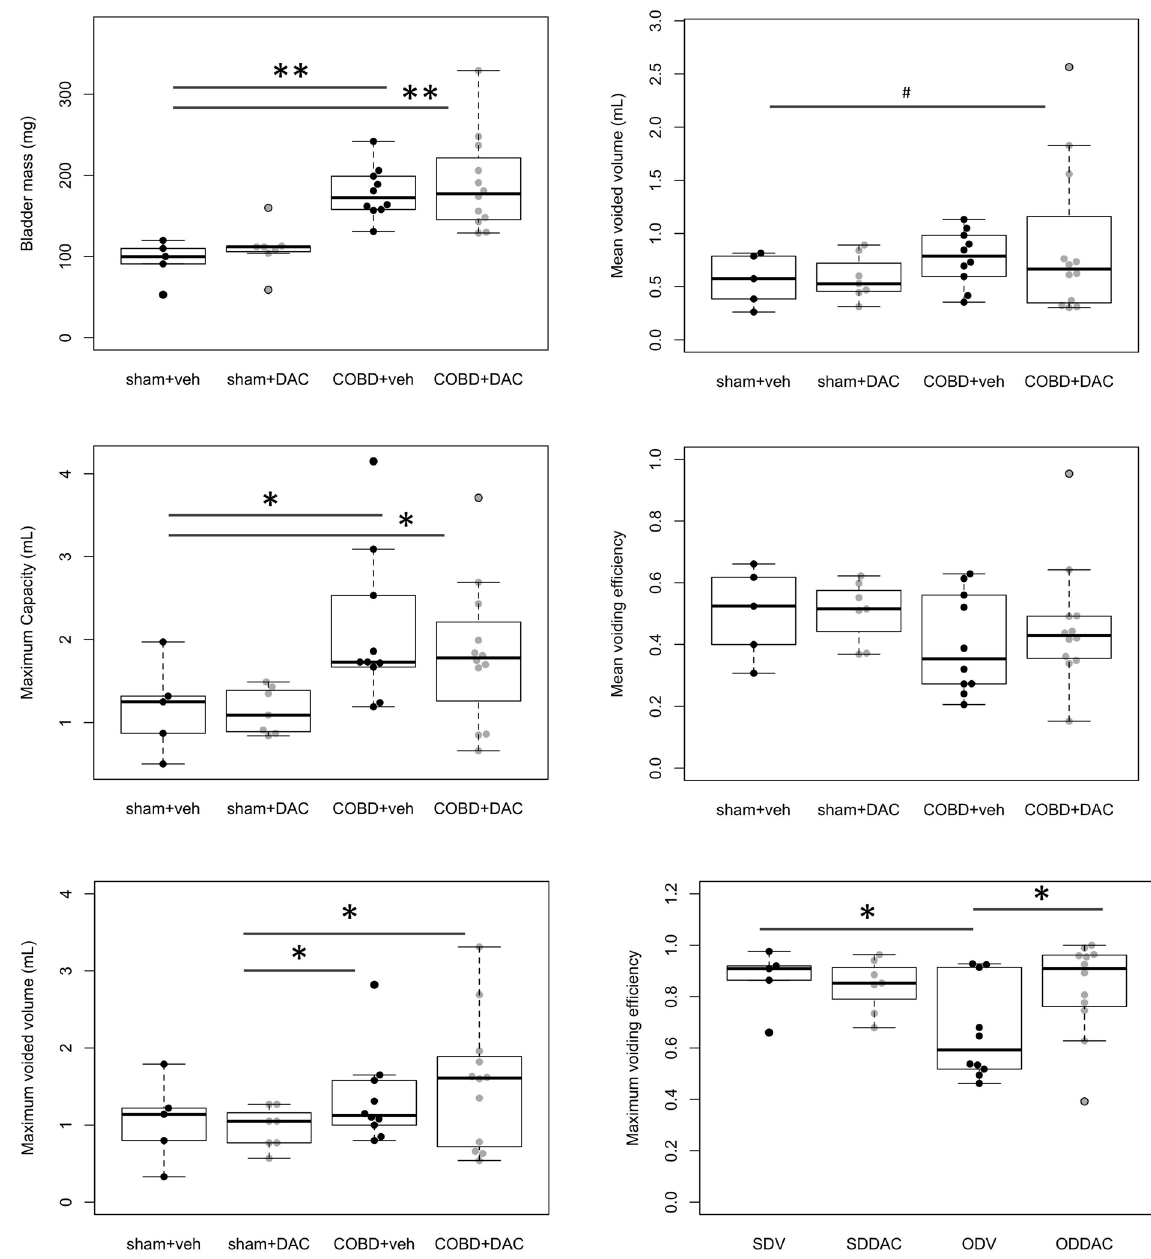
Figure 1. Decitabine treatment improves discrete aspects of bladder physiology and pathology during COBD. Previously we noted that 1 mg/kg/day decitabine (DAC) on physiology during obstruction (PBO) exacerbated the bladder dysfunction 26 . Here we examined DAC treatment in chronic obstructive bladder disease after de-obstruction (COBD). DAC treatment of COBD had either an improvement ( maximum voiding efficiency), no change ( bladder mass, maximum capacity, mean voided volume ) or a modest exacerbation in pathophysiology (maximum voided volume) , # p < 0.05, One-tailed t-test. *Two-tailed t-test, p < 0.05. **Two- tailed t-test, p <